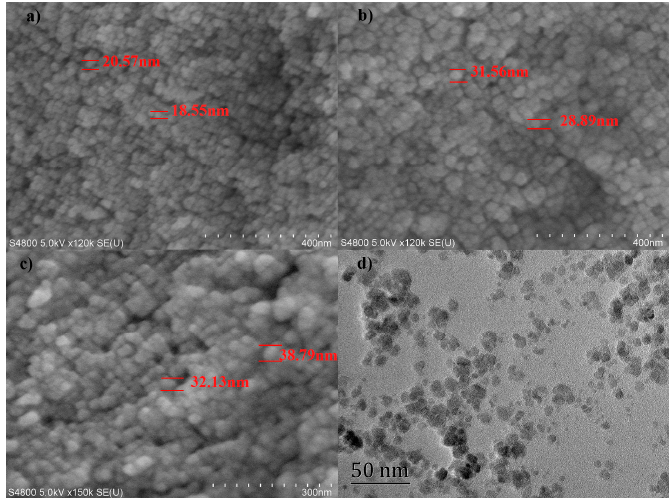
Figure 5. SEM images of: ( a ) LMNPs, 25%; ( b ) LMNPs, 50%; and ( c ) LMNPs, 100%; and TEM image of: ( d ) LMNPs, 50%.